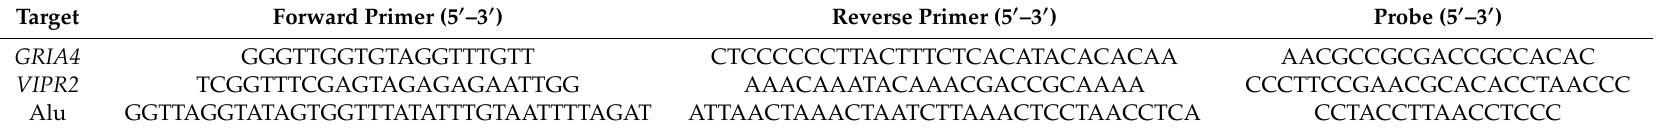
Table 4. Primers and probe sequences for MethyLight and ddPCR